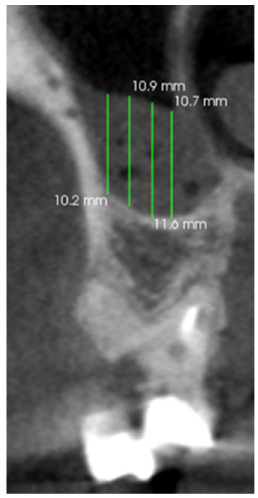
Figure 1. An image of a CBCT scan in coronal plane of the first maxillary molar and maxillary mu- cosal thickening measurement. mucosal thickening